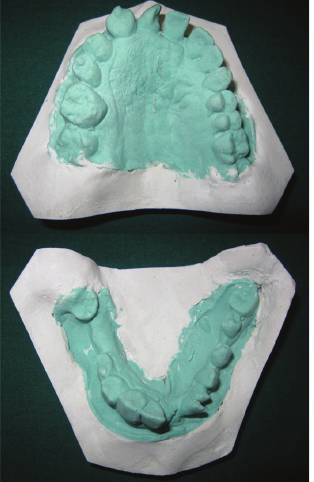
Figure 1: Unilateral enlargement of right side of the face. Note the asymmetry of the forehead, cheeks, nose, lips, chin, and the closed eye.